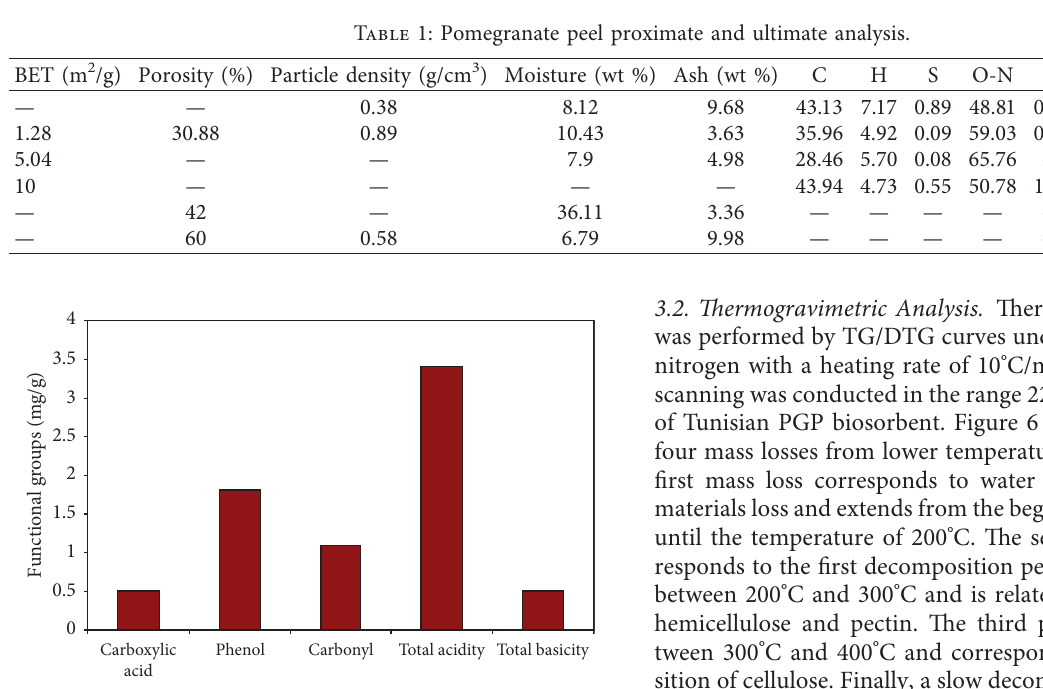
Figure 1: Relative contents of surface functional groups of Tunisian PGP.